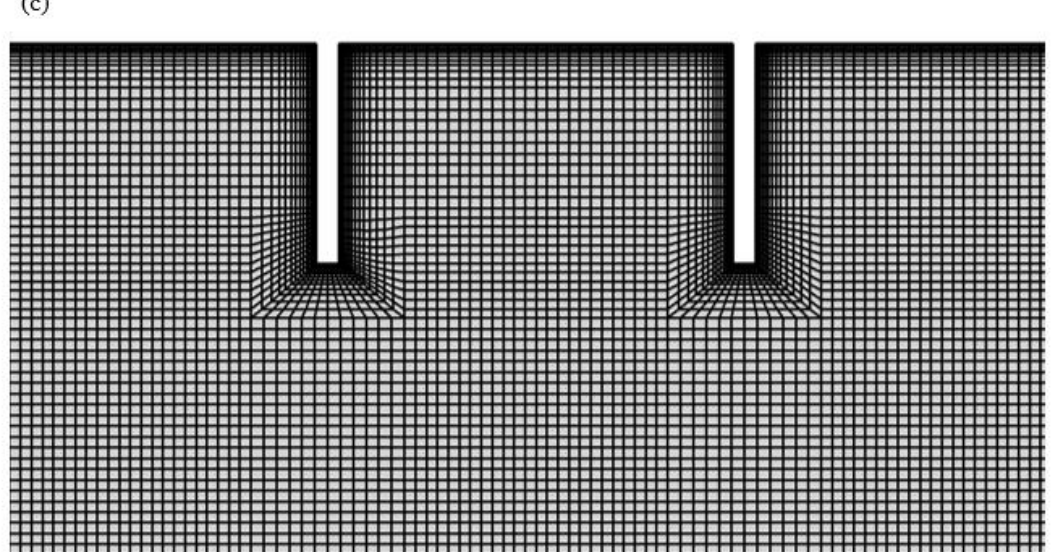
Figure 1. Schematic diagram of a two-dimensional wave tank developed to simulate the hydrodynamic performance of ( a ) sway-only floating ( b ) heave-only floating OWC in a wave flume; ( c ) computational mesh near the OWC.